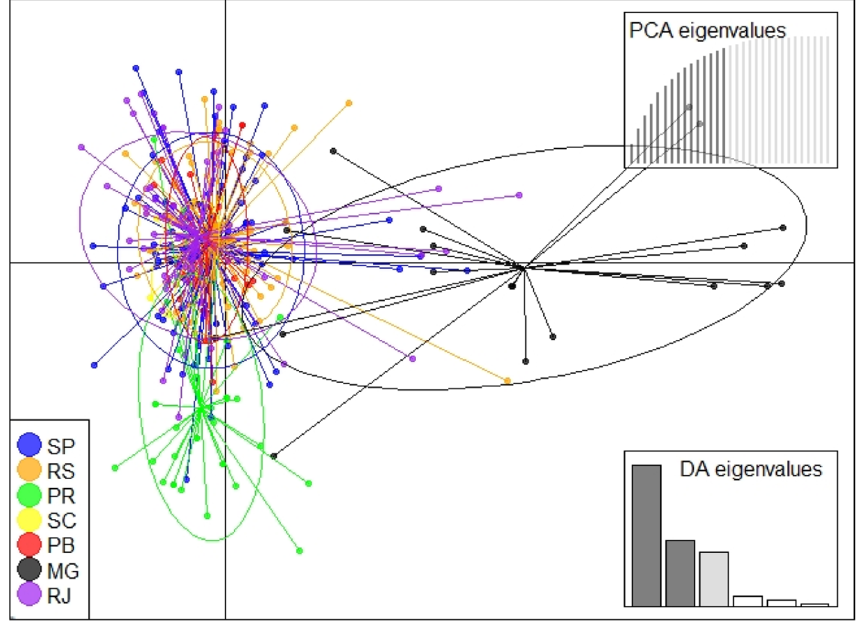
Figure 3. Discriminant analysis of principal components of bullfrog populations in Brazil. Acronyms represent different states: Paraíba (PB), Minas Gerais (MG), Rio de Janeiro (RJ), São Paulo (SP), Parana (PR), Santa Catarina (SC), and Rio Grande do Sul (RS). Metapopulations were organized by States due to the State-based production system implemented in the country.